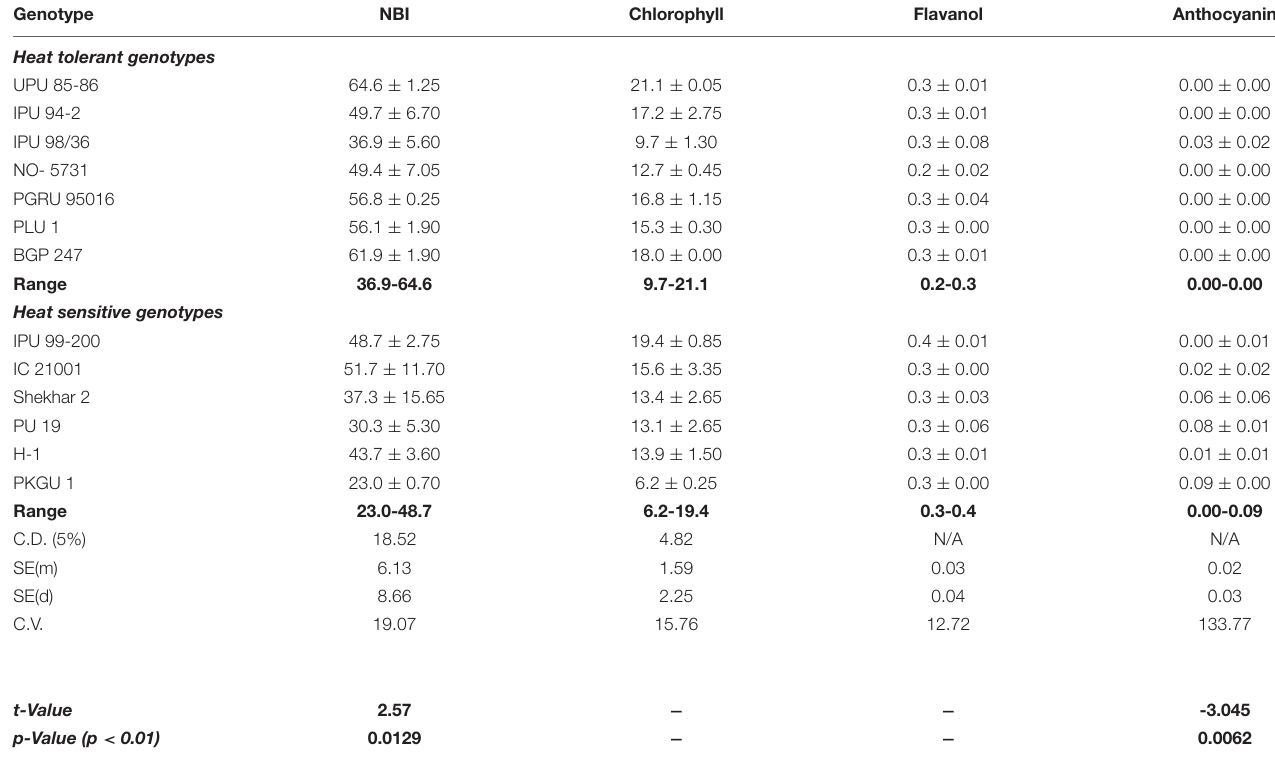
TABLE 6 | Leaf nitrogen balance index (NBI), chlorophyll (SPAD), epidermal flavanols, and anthocyanins in different urdbean genotypes grown under 42/30 ◦ C max/min